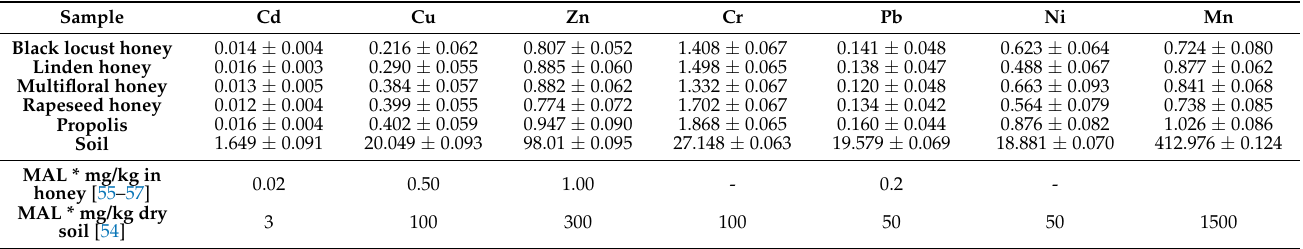
Table 4. Heavy metal concentrations (mean ± standard deviation) (mg/kg) in honey, propolis and soil samples collected from A2 area (entirely devoid of industrial activity, but with moderate agricultural